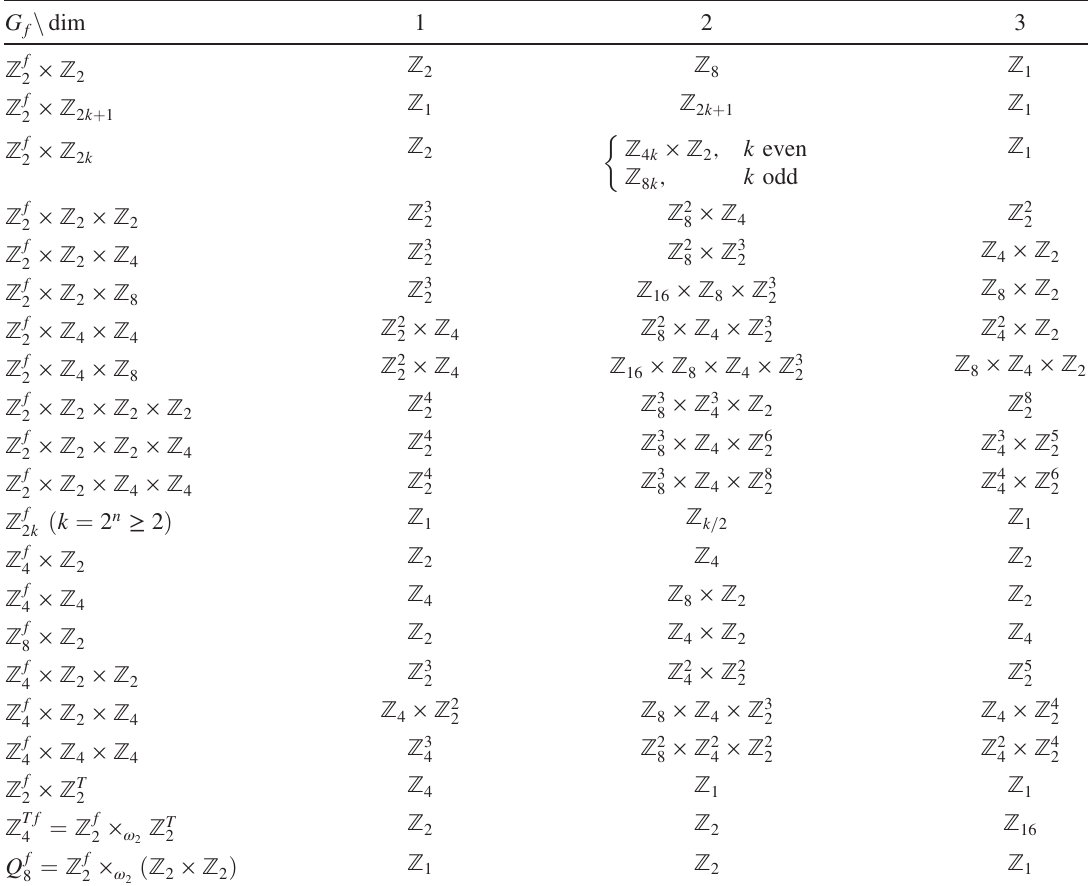
TABLE III. Classifications of FSPT phases with some simple fermionic symmetry group G dimensions. Invertible topological orders protected by Z f 2 only are not included in this table. G f n